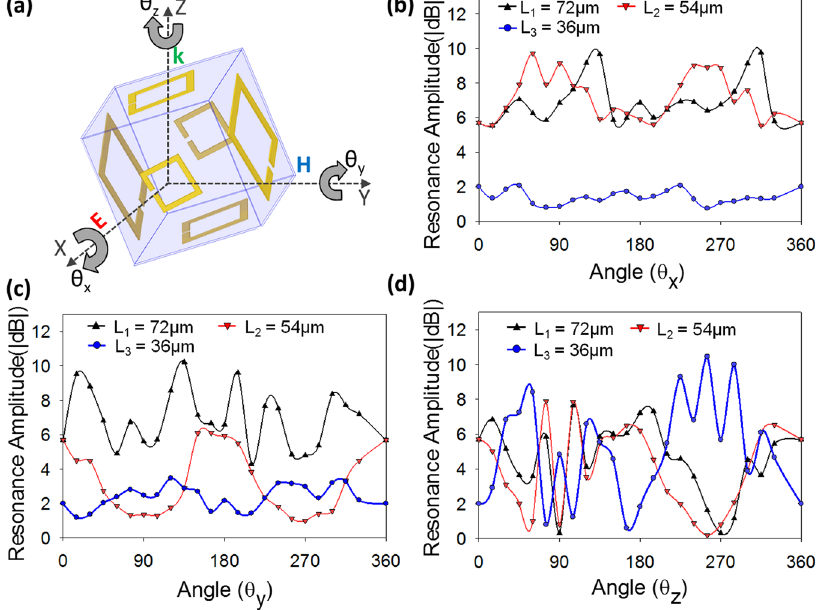
Figure 3. Simulation results for the rotation of the 3D cube. ( a ) Cubic inclinometer rotated about X-, Y-, and Z-axis at angles θ x , θ y , and θ z , respectively. Variation in resonance strength of each resonator obtained by simulating rotations along ( b ) X-axis, ( c ) Y-axis, ( d ) Z-axis in steps of 15° from 0–360° proving that for no two angles do the values of all three resonators overlap each other. The resonance amplitudes are obtained at the resonant frequencies of the L 1 (0.28 THz), L 2 (0.38 THz), and L 3 (0.55 THz)